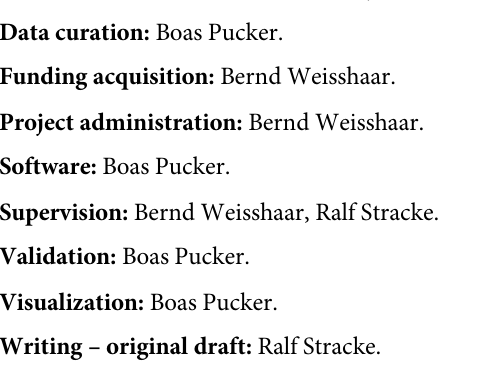
S2 Table. RNA-Seq raw data used for expression